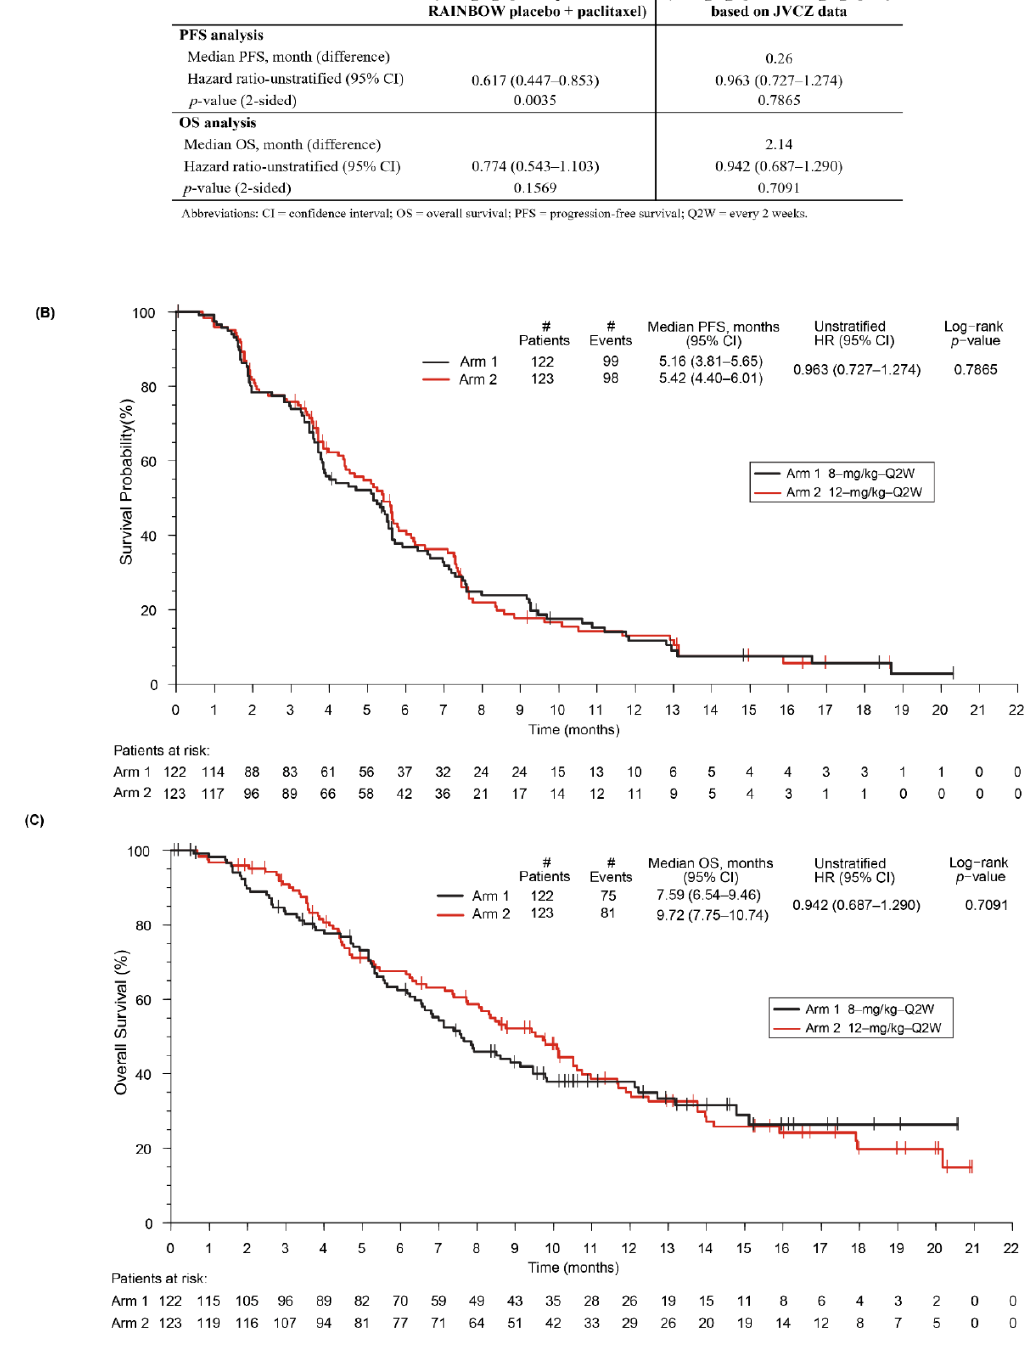
Figure 3. PFS and OS analysis of ramucirumab 12 mg/kg plus paclitaxel in JVCZ versus placebo plus paclitaxel in RAINBOW (Analysis 1) and 12 mg/kg versus 8 mg/kg within JVCZ (Analysis 2) ( A ), PFS ( B ), and OS ( C ). Abbreviations: OS—overall survival; PFS—progression-free survival.